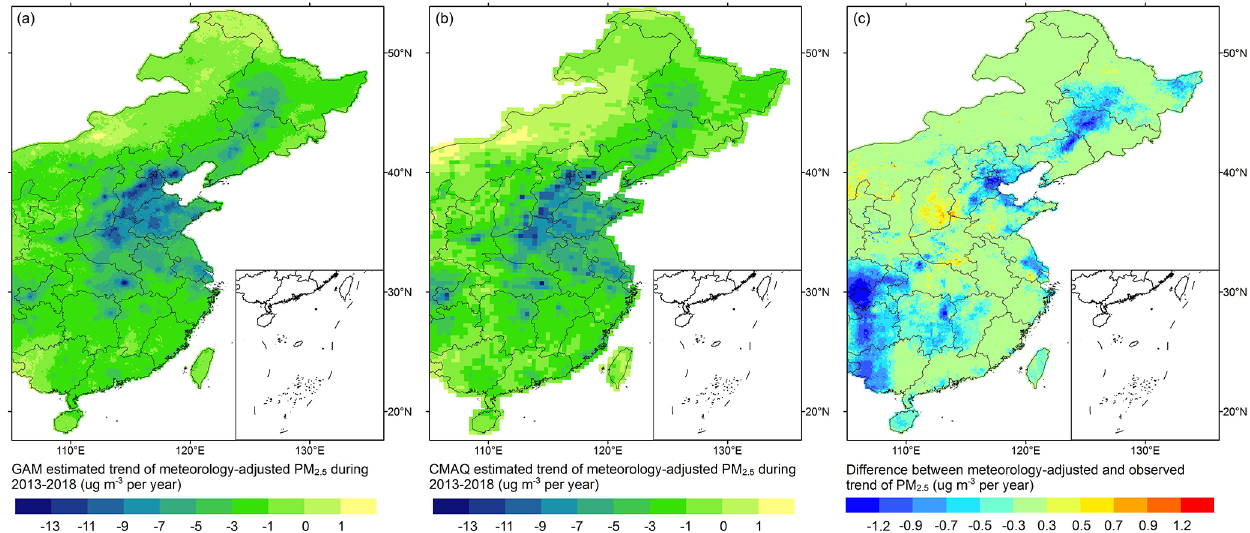
Figure 7. (a) Spatial distribution of the PM 2 . 5 decrease rate during 2013–2018 after adjusting for the meteorological effects using GAM. (b) Spatial distribution of the PM 2 . 5 decrease rate during 2013–2018 after adjusting for the meteorological effects using CMAQ. (c) The difference in the PM 2 . 5 decrease rate before and after the adjustment for the meteorological effects using GAM.